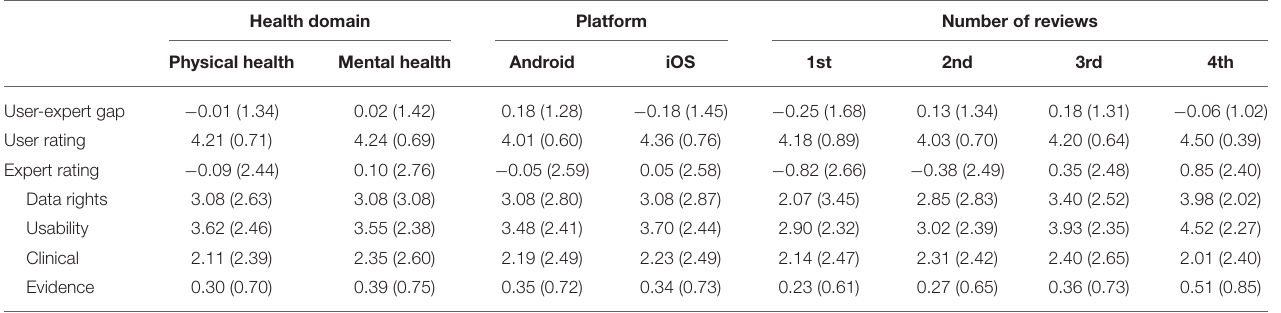
TABLE 2 | Comparison of user and expert ratings by health domain (physical health, mental health), platform (Android, iOS) and quartile in the number of reviews (1st, 2nd, 3rd, 4th). Health domain